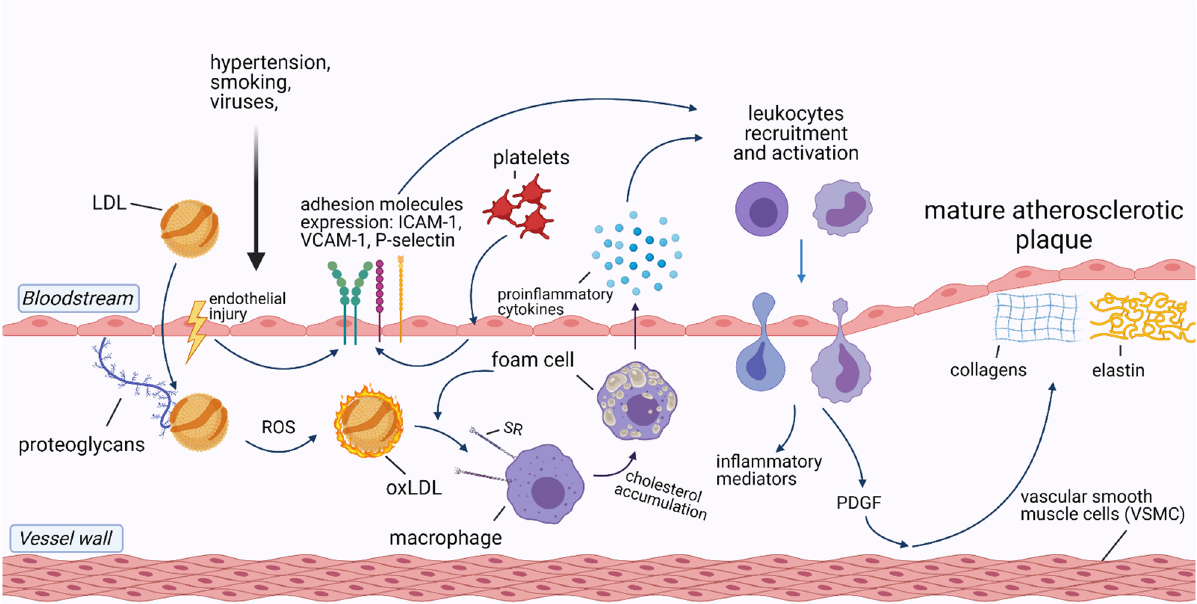
Figure 1. Pathophysiology of atherosclerotic plaque formation. Abbreviations: ICAM-1—intercellular adhesion molecule-1; LDL—low-density lipoprotein; oxLDL—oxidized LDL; PDGF—platelet-derived growth factor; ROS—reactive oxygen species; SR—scavenger receptor; VCAM-1—vascular cell adhesion protein 1. Created with Biorender.com, licensed version.